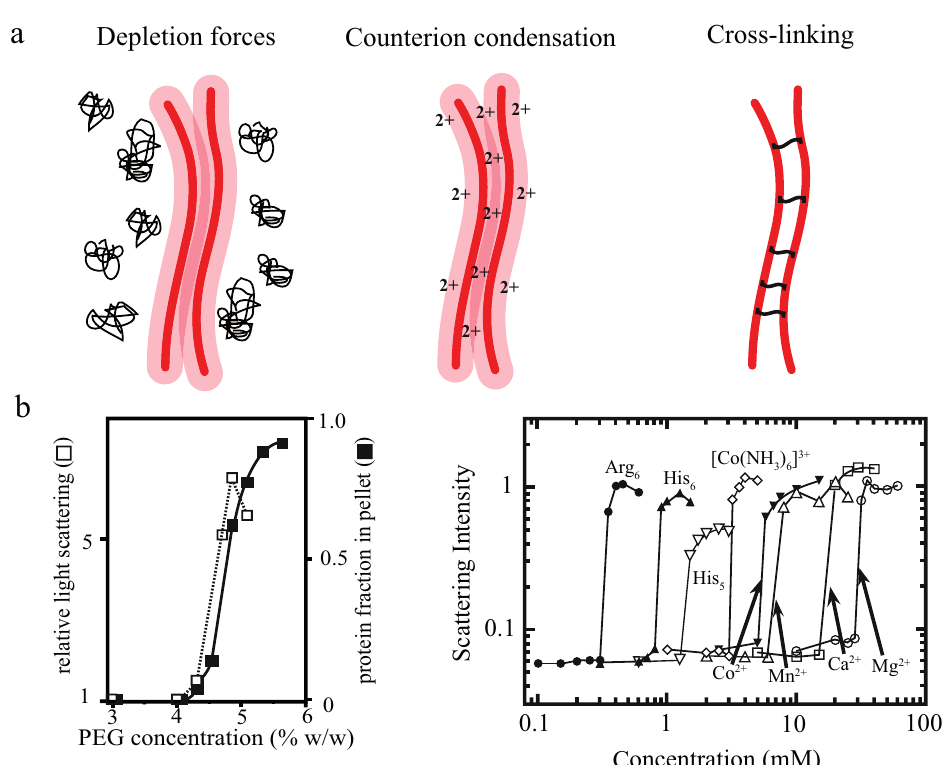
Figure 1. ( a ) Shown are three bundling mechanisms for actin filaments used for experiments described within this review. Actin filaments can be either bundled by fundamental physical effects such as depletion forces (e.g., induced by polyethylene glycol (PEG)) or counterion condensation but also by additional crosslinking proteins; ( b ) light scattering experiments revealed specific threshold concentrations and displayed rather sharp transitions from isotropically distributed filaments to ordered bundles when depletion forces or counterion condensation were employed in a concentration dependent manner. The graphs are adapted from Suzuki et al. as well as from J.X. Tang and P.A. Janmey